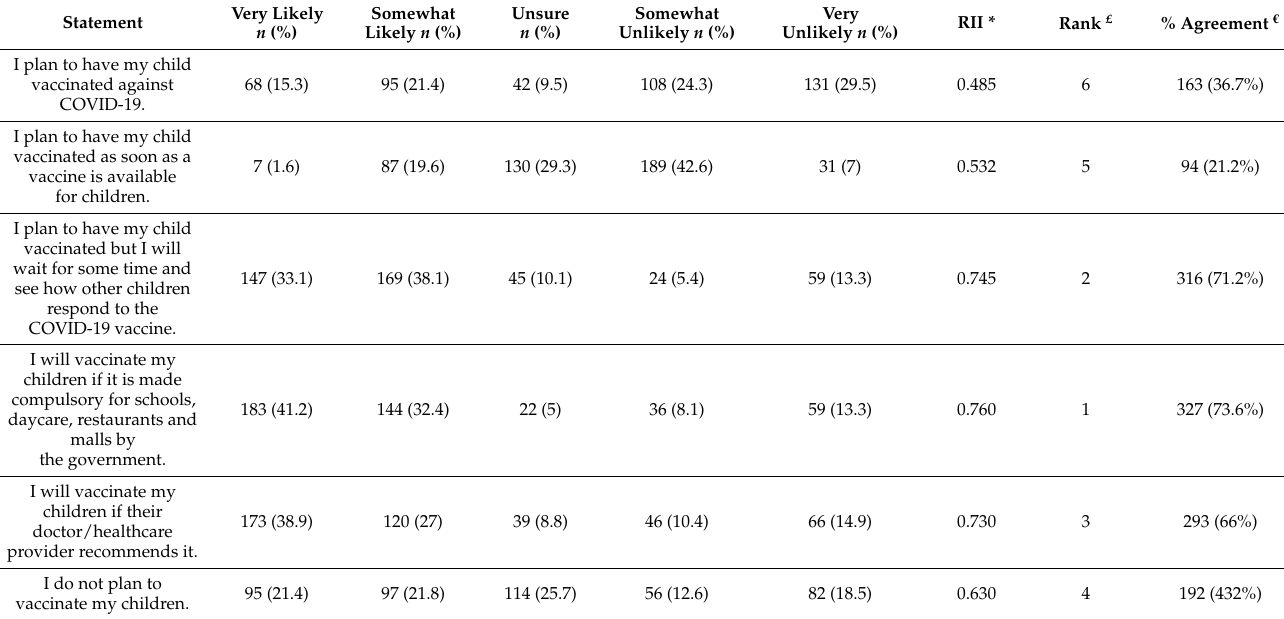
Table 2. Intention to have children vaccinated against COVID-19.